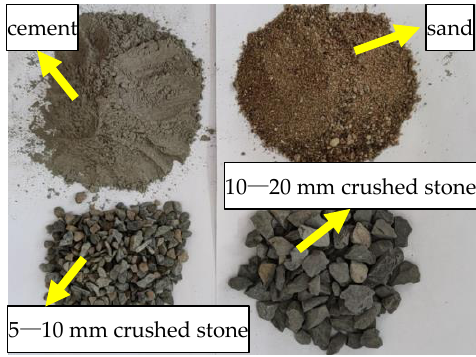
Figure 4. Concrete composition materials. Table 2. Concrete mix proportion.